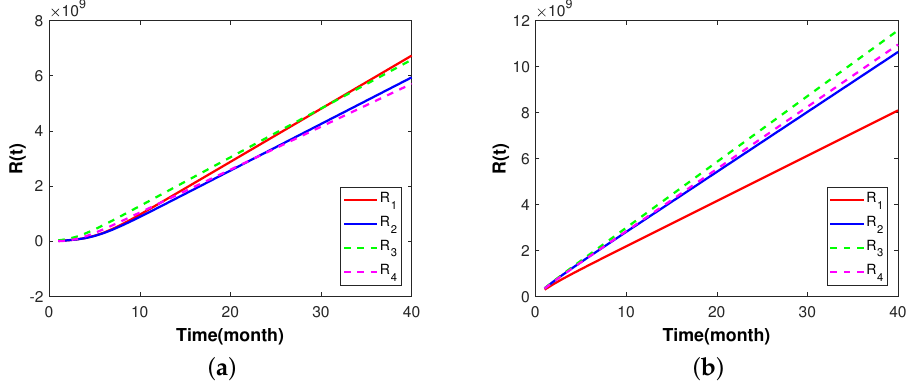
Figure 4. Changes in accumulated profits. ( a ) Based on the first group of parameters. ( b ) Based on the second group of